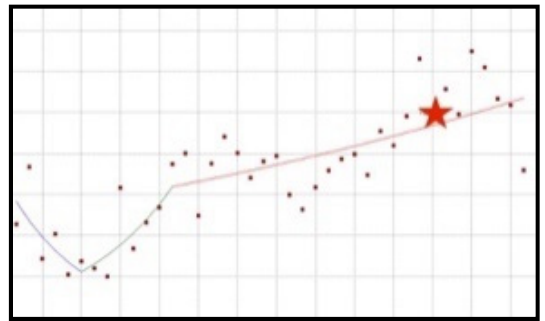
Figure 8. A schematic graph of the frequency of use of vitamin K in the respective quarters in the period from the first quarter of 2012 to the fourth quarter of 2021. The star denotes the moment of publication of the resolution concerning the ingredient. The height of placement of the symbol reflects the level of use of the ingredient. Vitamin K (Figure A34).